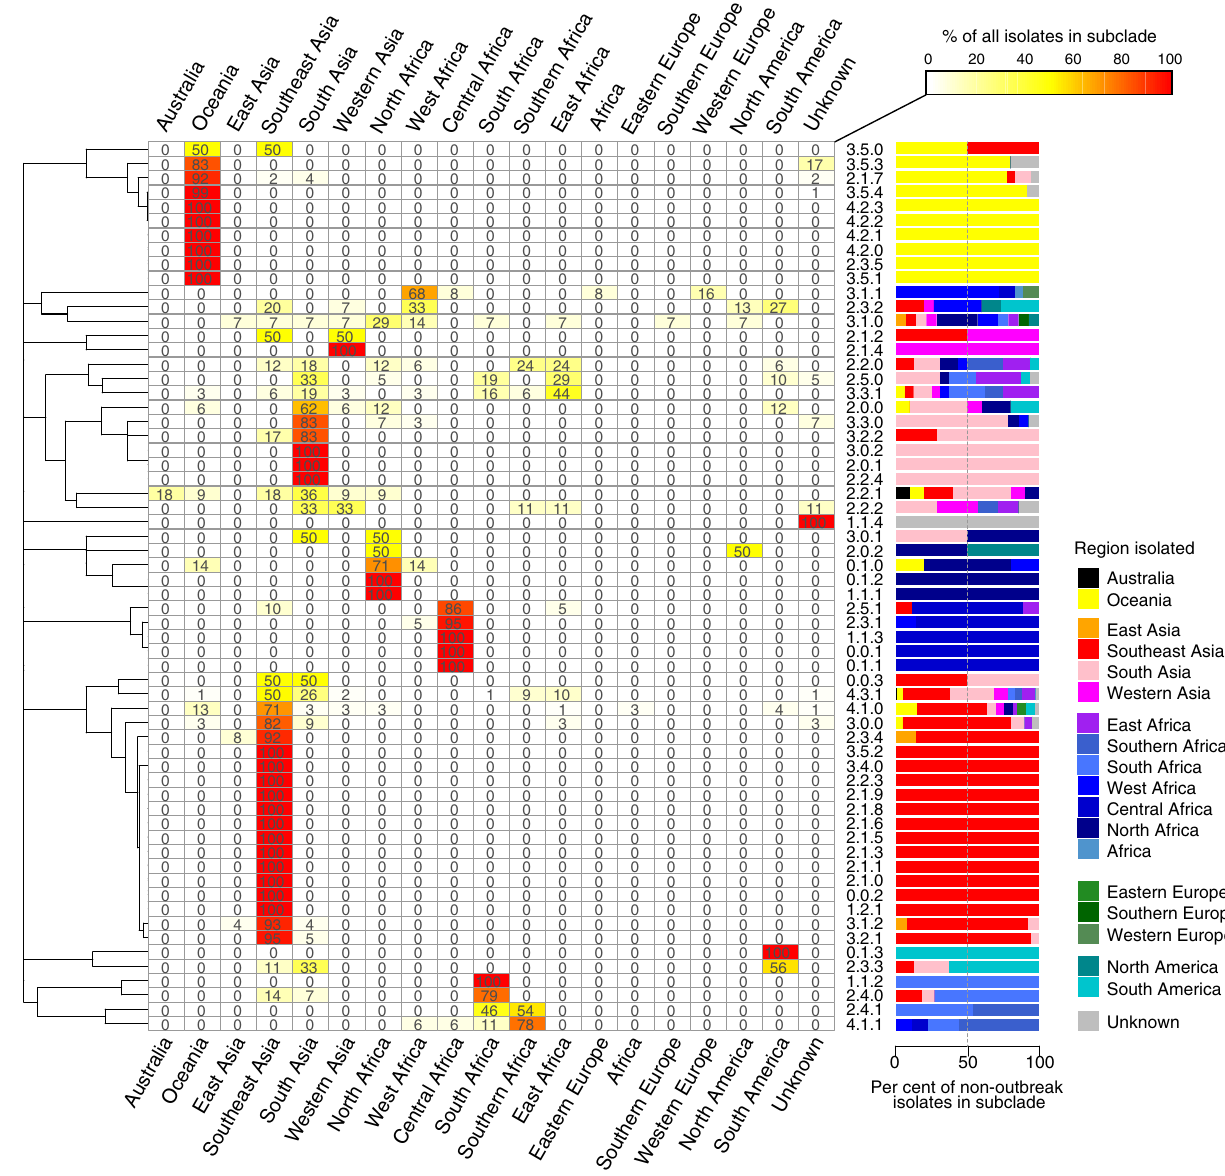
Figure 2 | Geographical clustering of S. Typhi subclades. Heatmap shows, for each subclade, the percentage of unique isolates originating from each of the geographical regions. Where groups of isolates from the same country and year belonged to the same subclade, this was classified as an ‘outbreak’ and the group is only represented once. The same data are represented as a scaled bar graph to the right. The full list of isolates by country and subclade is provided in Supplementary Data